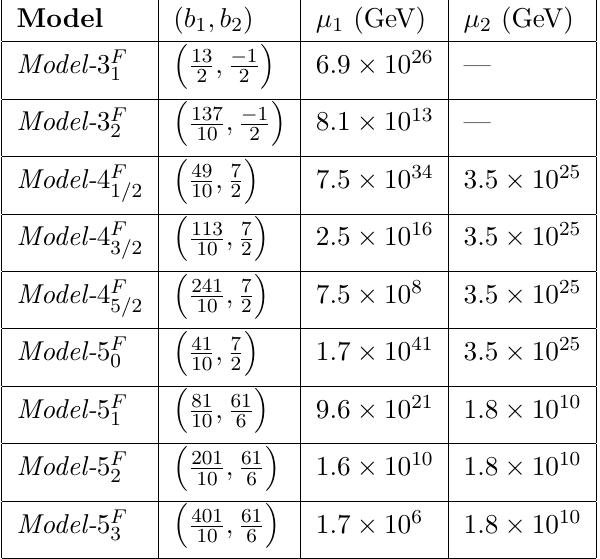
Table 10 . The coefficients in the β -functions and the energy scales µ 1 and µ 2 at which the Landau poles appear in, respectively, g and g for the different models. For the onset of the RG running, 1 2 we take g = 0 . 3587 and g = 0 . 6483 at µ = m , where m = 173 . 35 GeV [120]. 1 2 t t copies would only bring the scale down. While the inclusion of higher-order terms in the β -functions would change the location of the Landau pole to an extent, the difference is only quantitative and not